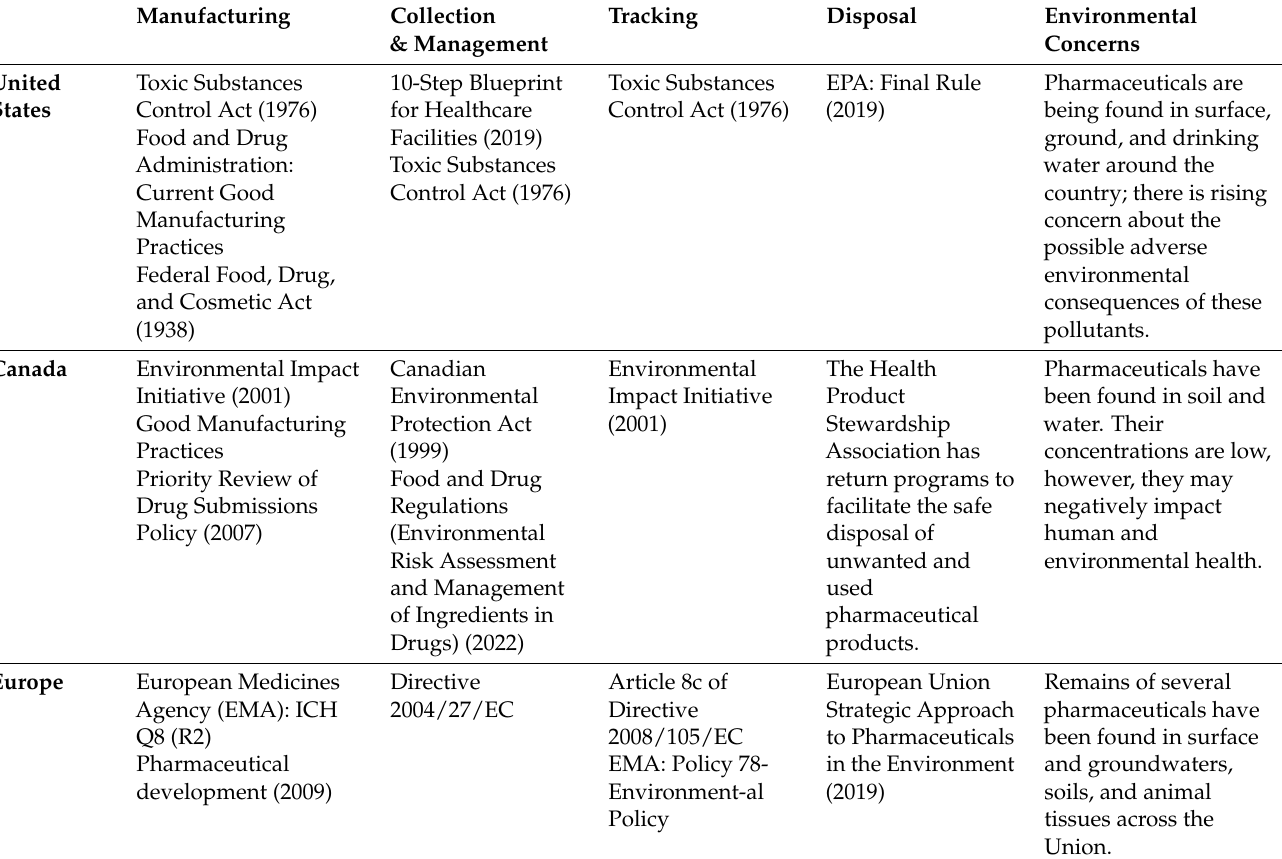
Table 2. Policies across the US, Canada, and Europe on pharmaceutical waste